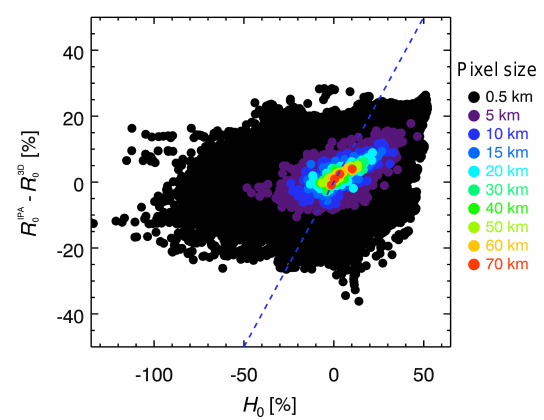
Figure 10. H 0 is only weakly correlated with reflectance biases (cid:49)R 0 (IPA-3-D reflectance) at scales below 15km, which means that, statistically, biases introduced by horizontal photon transport propagate primarily into transmittance, not albedo. This changes for larger